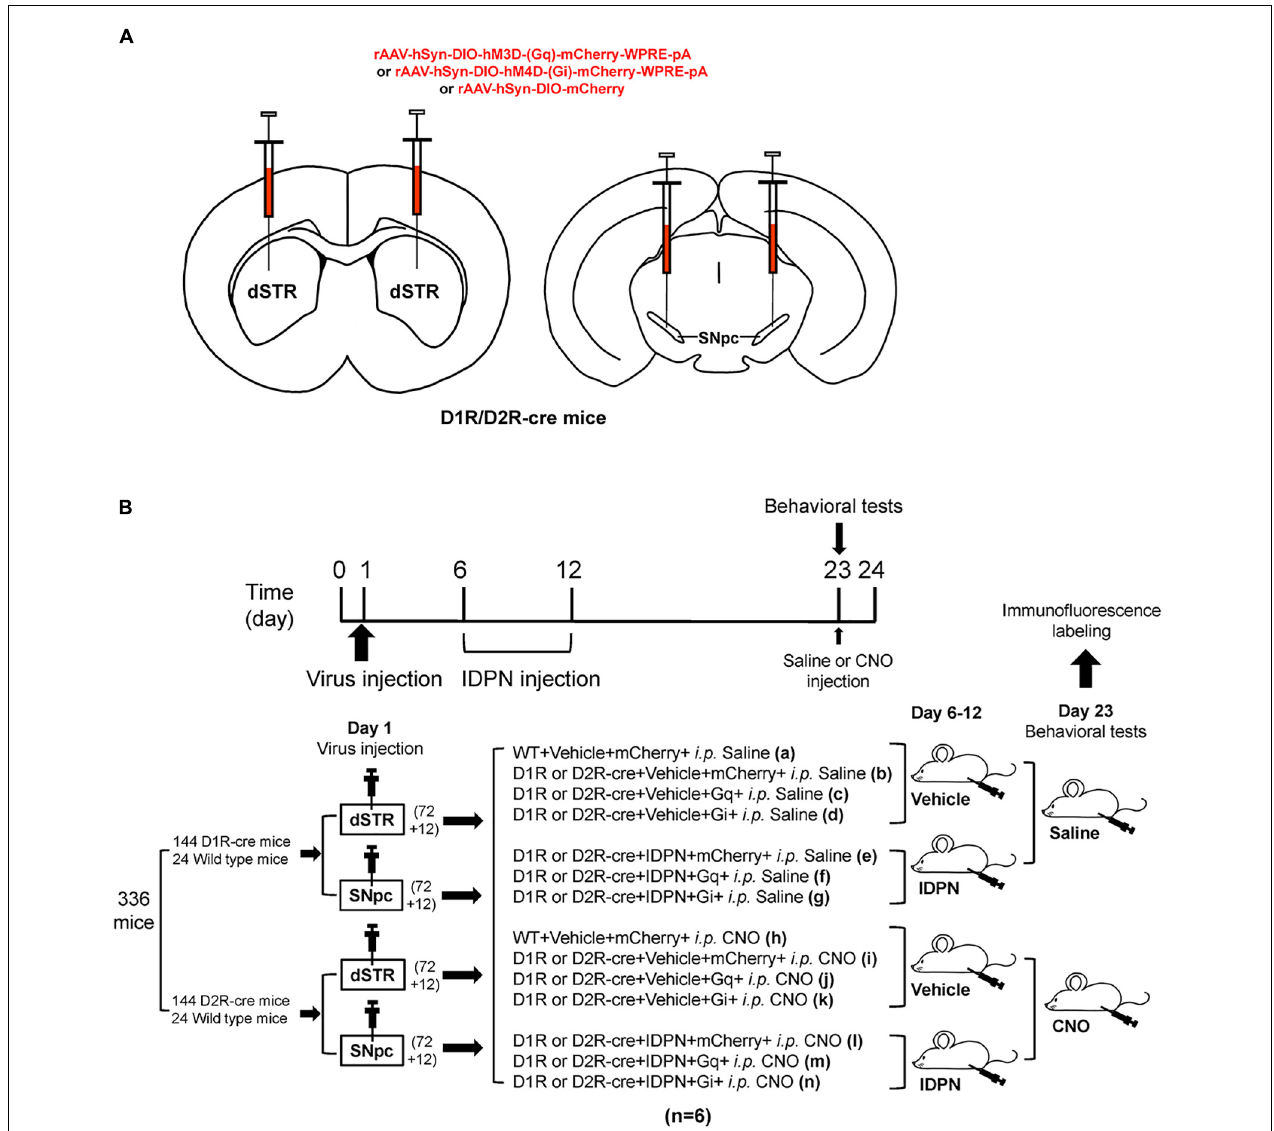
FIGURE 1 | Experimental design. (A) Schematic diagram of the virus injection area. (B) Experimental design timeline. A total of 336 mice [including 144 D1R-cre mice and 24 wild-type littermate (WT) mice, 144 D2R-cre mice, and 24 WT mice] participated in this experiment. After adaptive feeding for 1 week, they were randomly divided into four large groups (84 mice in each large group), among which 72 D1R-cre mice and 12 WT mice were further divided into two small groups, and 72 D2R-cre mice and 12 WT littermate mice were further divided into two small groups. On the first day, one small group of D1R-cre mice and WT littermate mice, one small group of D2R-cre mice and WT mice were injected with the virus in the bilateral dSTR (200 nL/side), the other two small groups were injected with the virus in the bilateral SNpc (200 nL/side). Eighty-four mice in each large group were randomly divided into 14 groups according to the injections of different drugs or virus, including WT + Vehicle + mCherry + i.p. Saline (group a), D1R or D2R-cre + Vehicle + mCherry + i.p. Saline group (group b), D1R or D2R-cre + Vehicle + Gq + i.p. Saline group (group c), D1R or D2R-cre + Vehicle + Gi + i.p. Saline group (group d), D1R or D2R-cre + IDPN + mCherry + i.p. Saline group (group e), D1R or D2R-cre + IDPN + Gq + i.p. Saline group (group f), D1R or D2R-cre + IDPN + Gi + i.p. Saline group (group g), WT + Vehicle + mCherry + i.p. CNO group (group h), D1R or D2R-cre + Vehicle + mCherry + i.p. CNO group (group i), D1R or D2R-cre + Vehicle + Gq + i.p. CNO group (group j), D1R or D2R-cre + Vehicle + Gi + i.p. CNO group (group k), D1R or D2R-cre + IDPN + mCherry + i.p. CNO group (group l), D1R or D2R-cre + IDPN + Gq + i.p. CNO group (group m) and D1R or D2R-cre + IDPN + Gi + i.p. CNO group (group n) ( n = 6 mice in each group). Mice in the groups a, b, e, h, i, and l were injected with a control virus (mCherry). Mice in the groups c, f, j, and m were injected with hM3Dq. Mice in group d, g, k, and n were injected with hM4Di. After the virus injection, all mice were back to the cage to rest for 4 days (days 2–5). On days 6–12, mice in groups e, f, g, l, m, and n were intraperitoneally injected with IDPN at 10:00 a.m. once daily, and mice in the other groups were intraperitoneally injected with 0.9% saline (Vehicle, contrast with IDPN). On the 23rd day, mice in the a–g groups were intraperitoneally injected with 0.9% saline (contrast with CNO), and mice in the h–n groups were intraperitoneally injected with clozapine N-oxide (CNO, Sigma, St. Louis, MO, United States, 1 mg/kg). Thirty minutes later, behavioral tests were carried out to compare the differences between the groups. Brain tissues for immunofluorescence labeled were collected on day